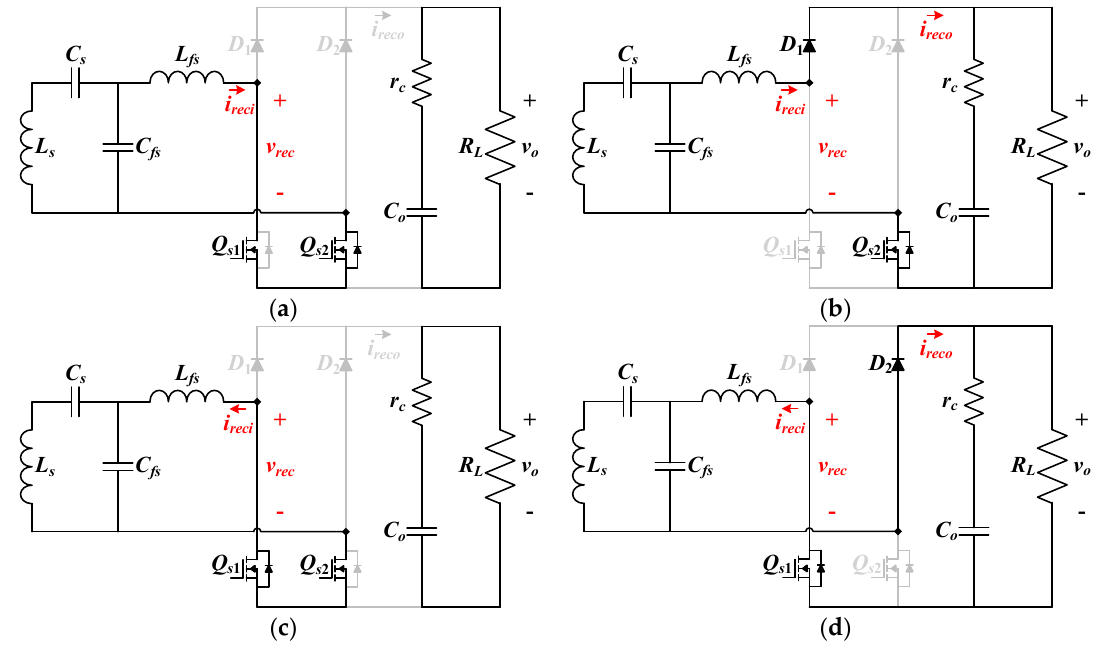
Figure 4. Equivalent circuits for each mode: ( a ) Mode 1; ( b ) Mode 2; ( c ) Mode 3; ( d ) Mode 4.